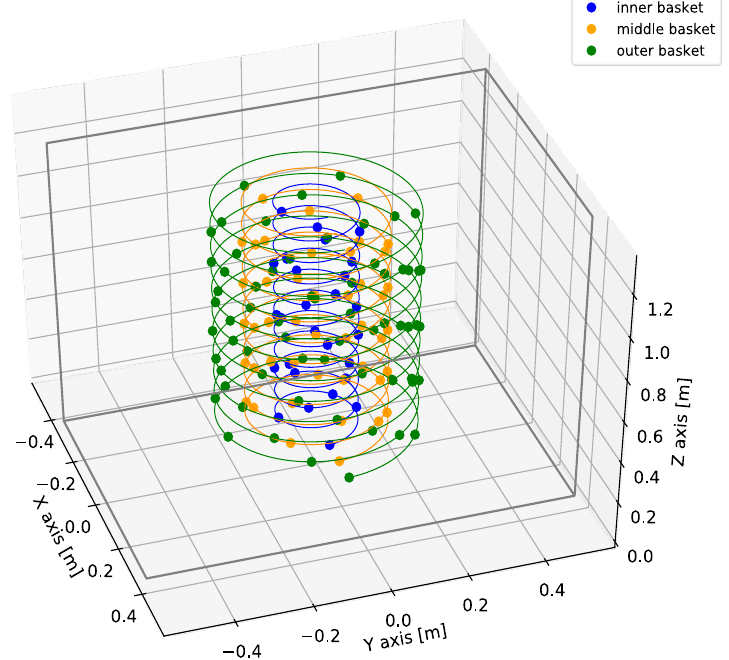
Figure 9. DTS data points.